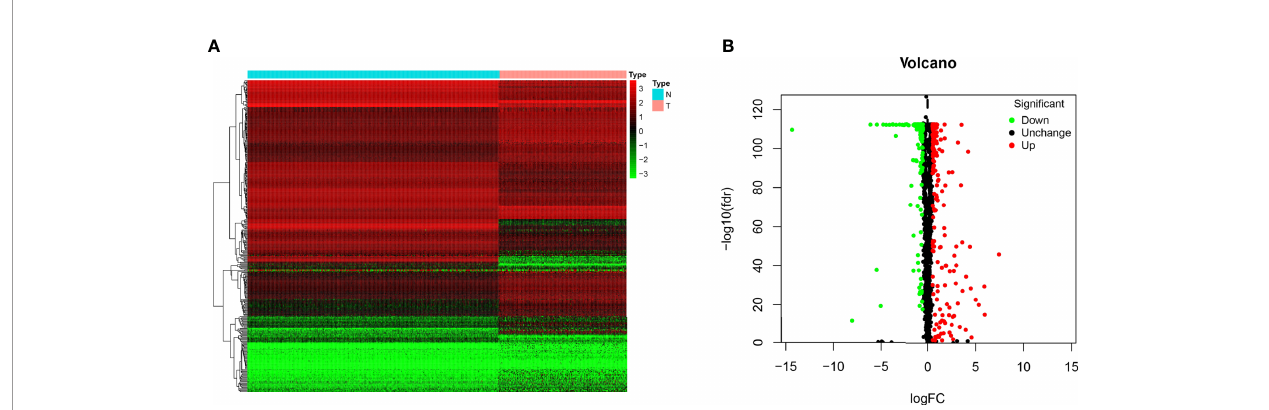
FIGURE 1 | The differentially expressed RBPs in STS. (A) Heat map of 329 differentially expressed RBPs between tumor (T) and normal fat tissue (N) samples based on FDR < 0.05 and |logFC|>0.5; (B) Volcano plot of all RBPs. The red dots represent up-regulated RBPs. The green dots represent down-regulated RBPs. The black dots represent RBPs with no signi fi cant changes between tumor (T) and normal fat tissue (N) samples based on FDR < 0.05 and |logFC|>0.5.